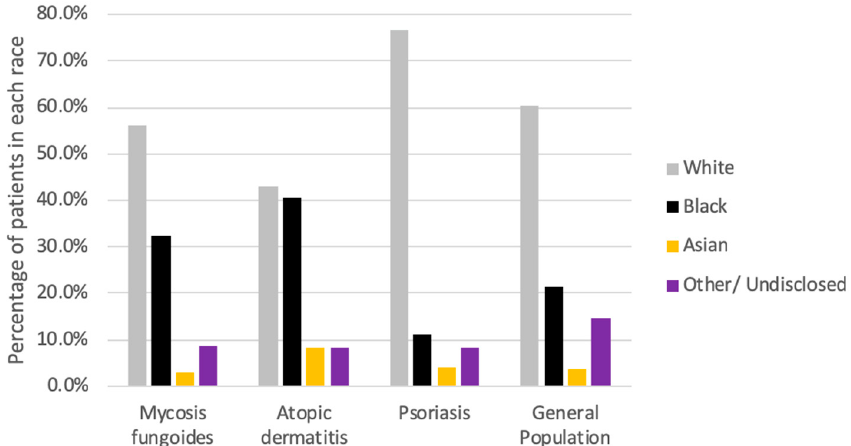
Figure 1. Racial backgrounds of all patients 18 years and older with a diagnosis of mycosis fungoides (MF), atopic dermatitis (AD), or psoriasis and within the general population who presented to the Johns Hopkins Hospital System between January 1, 2013 and January 1, 2019.